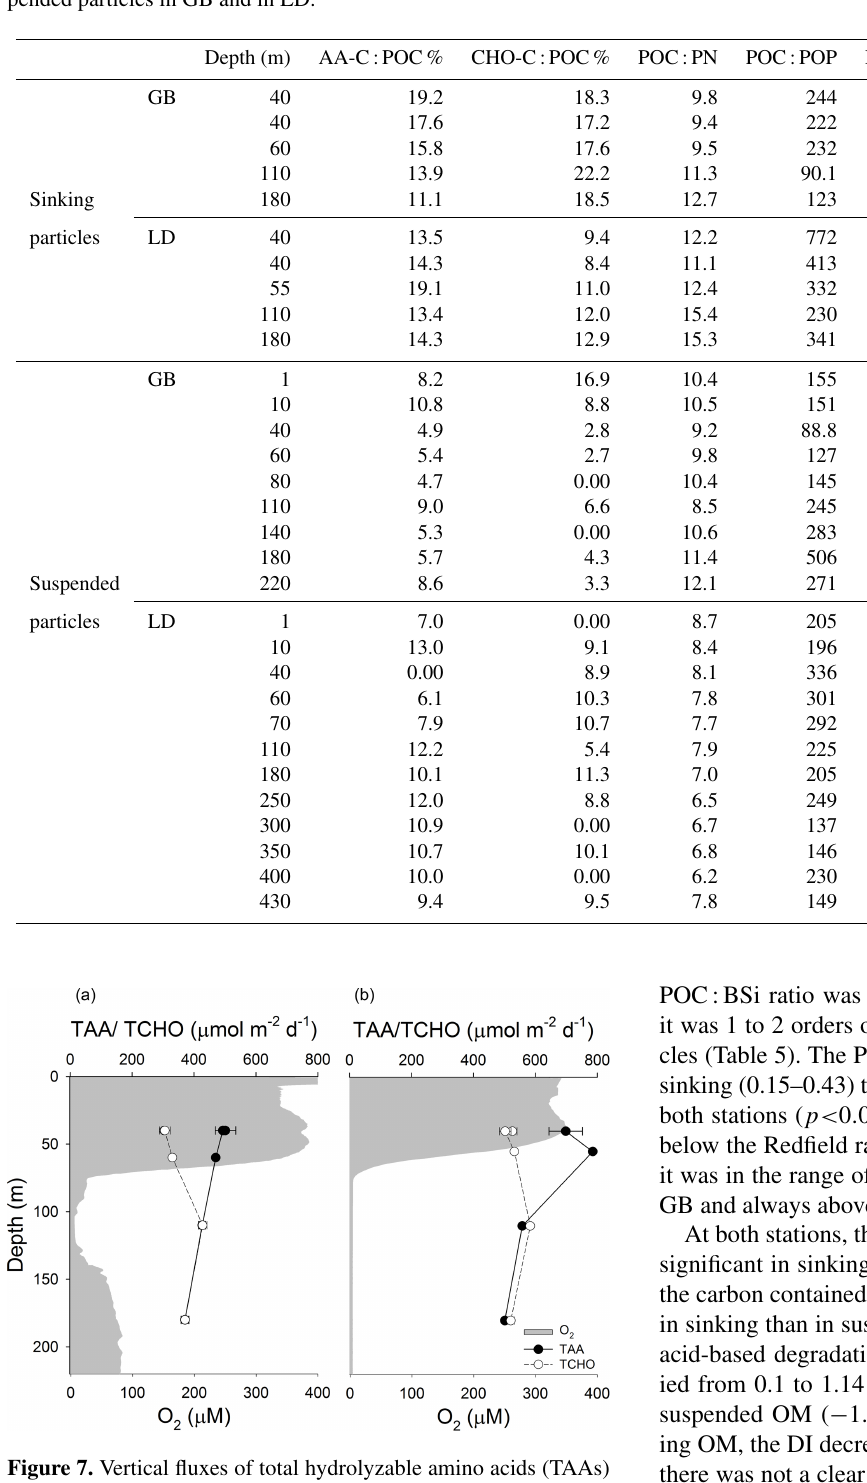
Table 5. Amino acids (AAa), carbohydrates (CHOs), elemental molar ratios and amino-acid-based degradation index of sinking and sus- pended particles in GB and in LD.